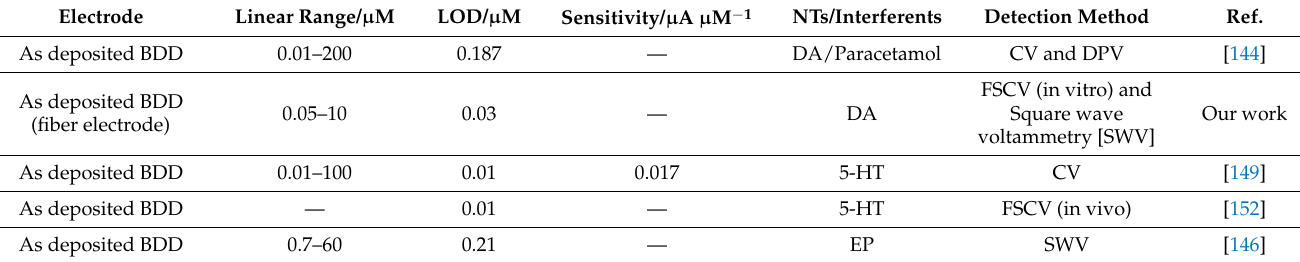
Table 2. Neurotransmitter sensing performance of untreated